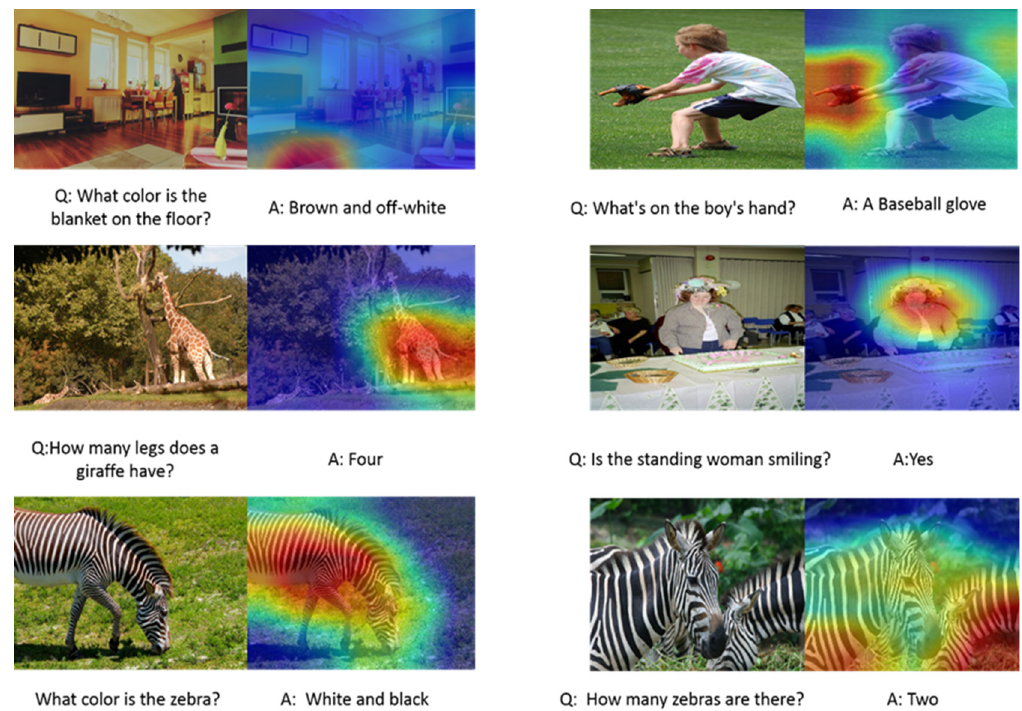
Figure 3. Typical experiment results of related images and questions from the VQA2.0 dataset. The image on the left of each row is related to the question. The image on the right of each row is a visualization of the attention maps related to the question. The text below the image is the question and answer related to the image.